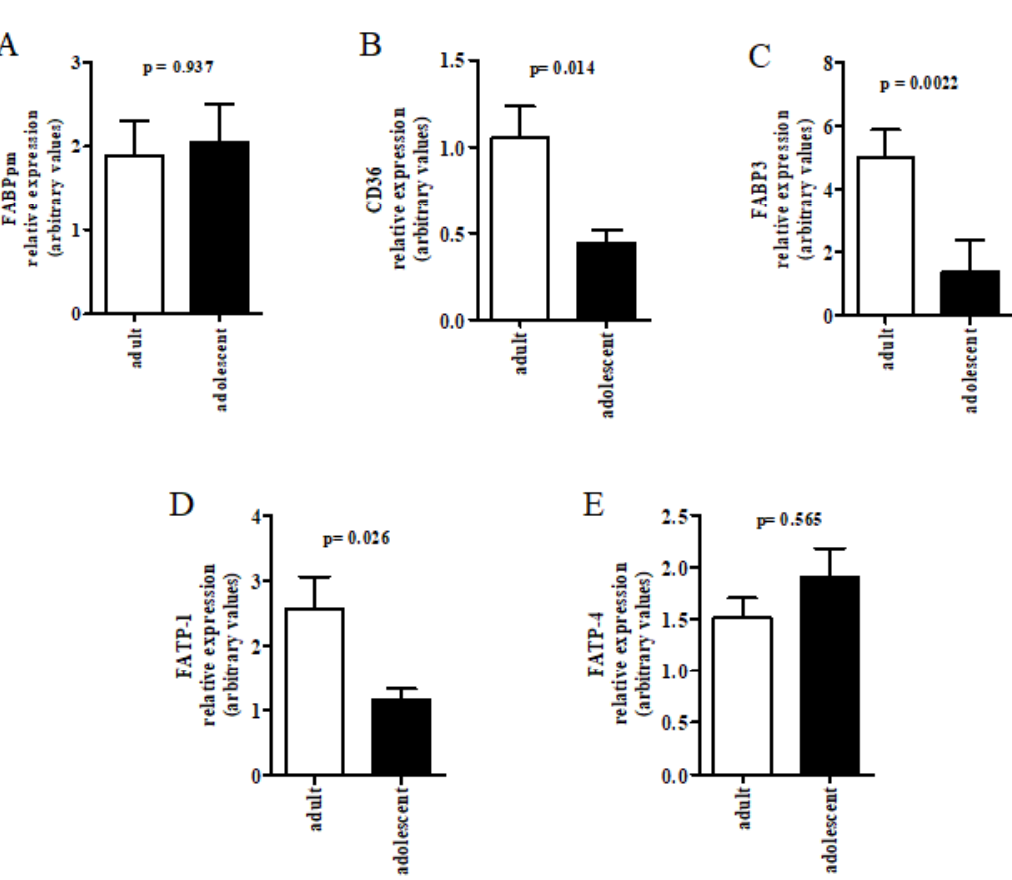
Figure 1. Placental gene expression of ( A ) FABPpm; ( B ) FAT/CD36; ( C ) FABP3; ( D ) FATP1 and ( E ) FATP4 was evaluated in adolescent ( n = 15) and adult mothers ( n = 15) after normalization with reference gene GAPDH. Quantification was performed by qRT-PCR. Results are expressed as relative expression mean ± SEM. p < 0.05 was considered significantly different according to unpaired t test.